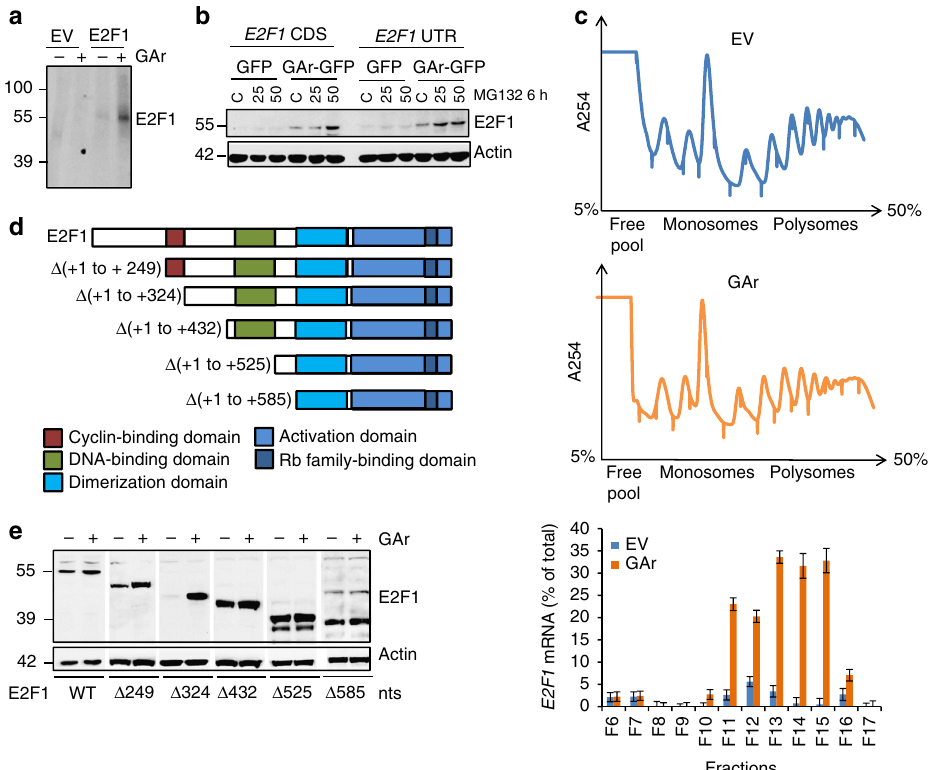
Fig. 4 GAr-induced mRNA translation stress stimulates E2F1 synthesis. a Autoradiograph shows the effect of GAr on newly synthesised E2F1 levels following 35 S-Met pulse labelling in the presence of a proteasome inhibitor (20 µ M MG132) followed by E2F1 immunoprecipitation. b Western blots showing GAr-dependent induction of E2F1 from constructs carrying the untranslated (UTR) regions of the E2F1 mRNA (E2F1 UTR), or the coding sequence alone (E2F1 CDS). c Polysome pro fi ling and RT-qPCR analysis of E2F1 mRNA in cells expressing the GAr or EV. The upper panels show polysome pro fi les. The lower panel shows the relative E2F1 mRNA levels (%) from total mRNA normalised against actin. The values represent the mean data from three independent experiments with s.d. d Schematic representation of functional domains of E2F1 deleted from the 5 ′ of the CDS. The +1 indicated the fi rst AUG of the CDS. e Western blots showing the expression of E2F1 deletion mutants with and without GAr expression. Western blots represent n ≥ 3, actin was used as a loading